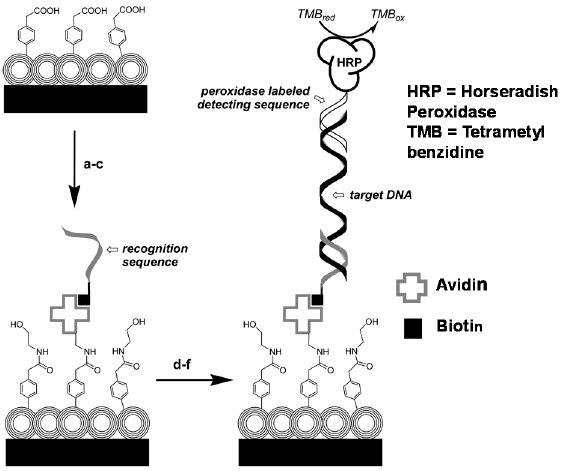
Figure 21. DNA sensors for human papillomavirus oncogene detection. From Reference [130] with permission of the American Chemical Society.